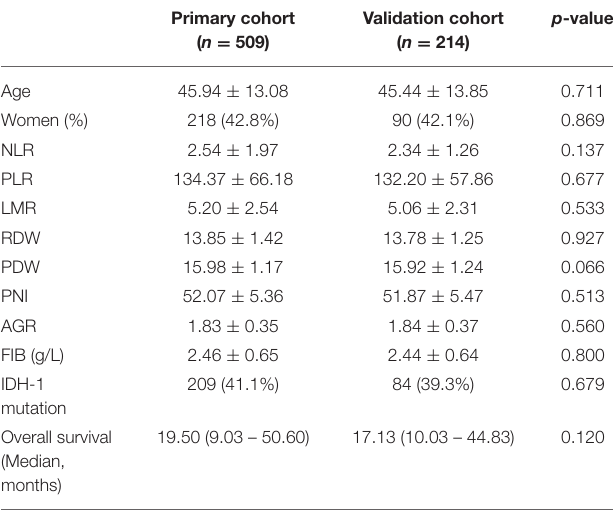
TABLE 1 | Baseline